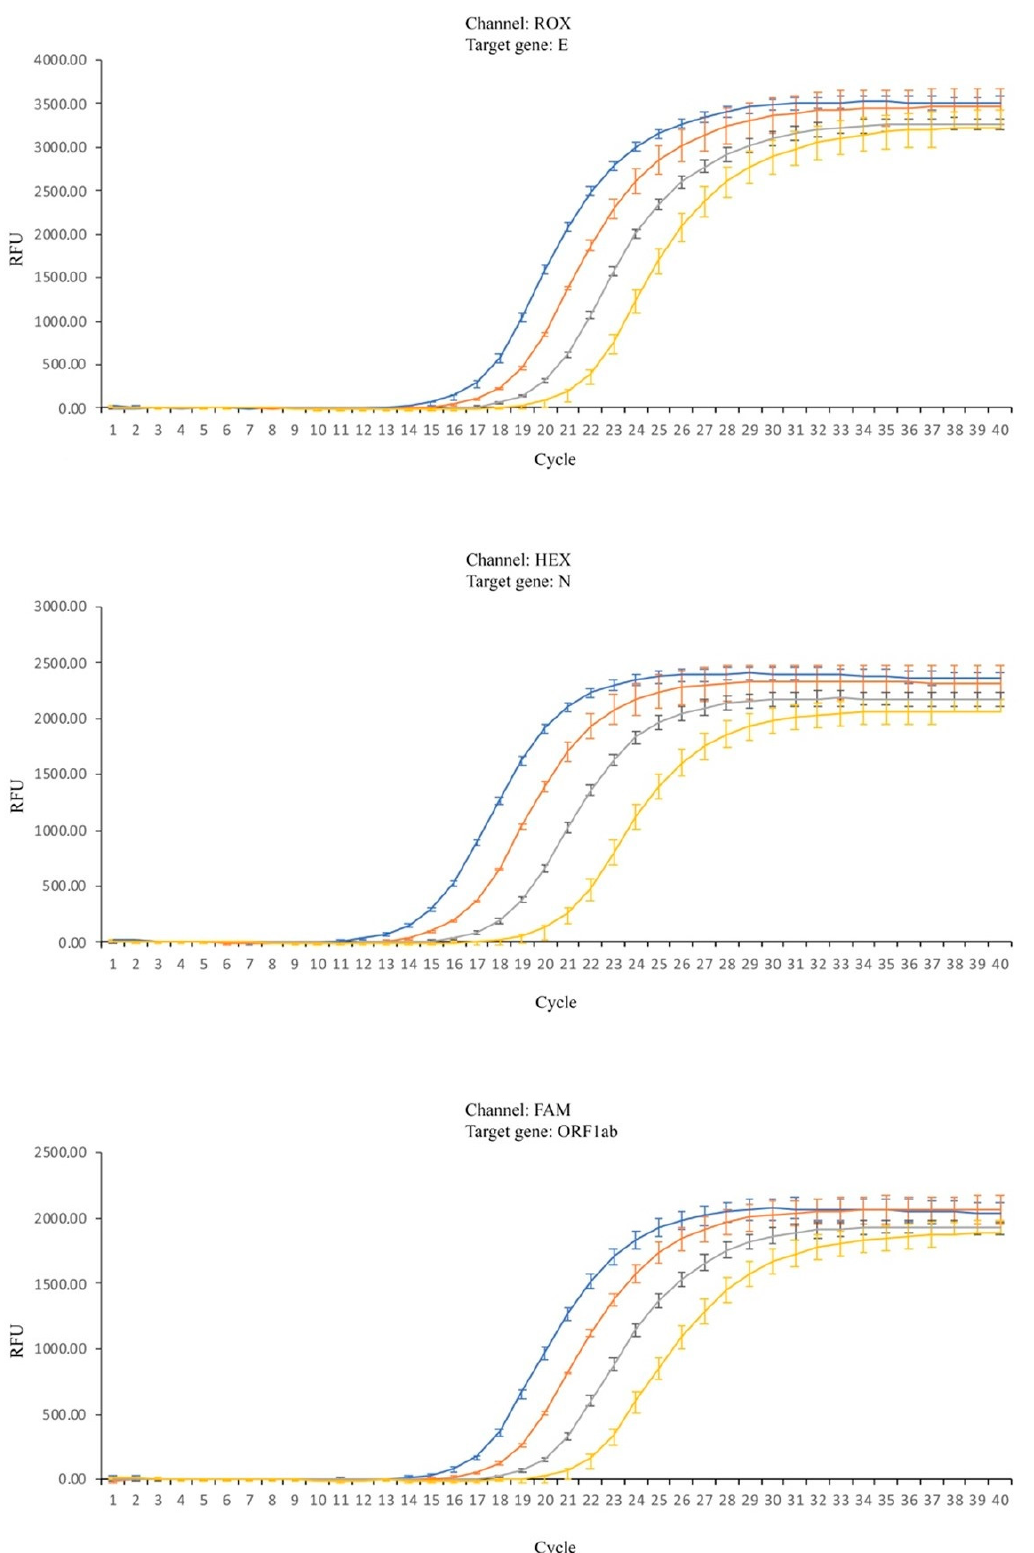
Figure 2. RT-PCR amplification reactions for the three viral target genes. Blue lines—no saliva; orange lines—2 µ L of saliva; gray lines—4 µ L of saliva; yellow lines—6 µ L of saliva; Standard deviation (SD) represented by vertical